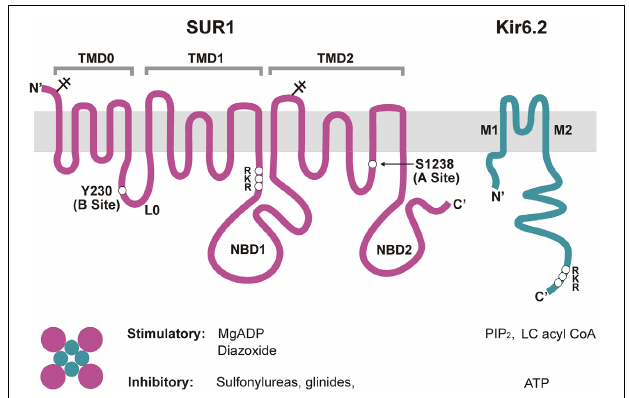
FIGURE 2 | Molecular composition and regulation of K ATP channels. Pancreatic K ATP channels are hetero-octamers of four Kir6.2 subunits, which form the K + conducting pore, and four regulatory SUR1 subunits. Shown on the top are transmembrane topologies of the two subunits. SUR1 has three transmembrane domains, TMD0, TMD1, and TMD2, two cytoplasmic nucleotide binding domains, NBD1 and NBD2, and a cytoplasmic linker L0 that connects TMD0 to the ABC core structure of the protein. Kir6.2 has two transmembrane helices, M1 and M2, and cytoplasmic N- and C-terminus. Physiological and pharmacological ligands that impact channel function are shown below. Mg-nucleotides interact with NBDs of SUR1 to activate the channel, whereas ATP binding at Kir6.2 closes the channel. PIP 2 and LC acyl CoAs also interact with Kir6.2 but stimulate channel activity. Sulfonylureas and glinides inhibit, whereas diazoxide stimulates channel activity by interacting with primarily SUR1. For detailed discussion on the involvement of each subunit in channel regulation by the various physiological and pharmacological ligands please refer to the main text. Locations of the RKR motifs in SUR1 and Kir6.2 are marked. Y230 and S1238, SUR1 residues critical for site B and site A of the glibenclamide binding pocket are also